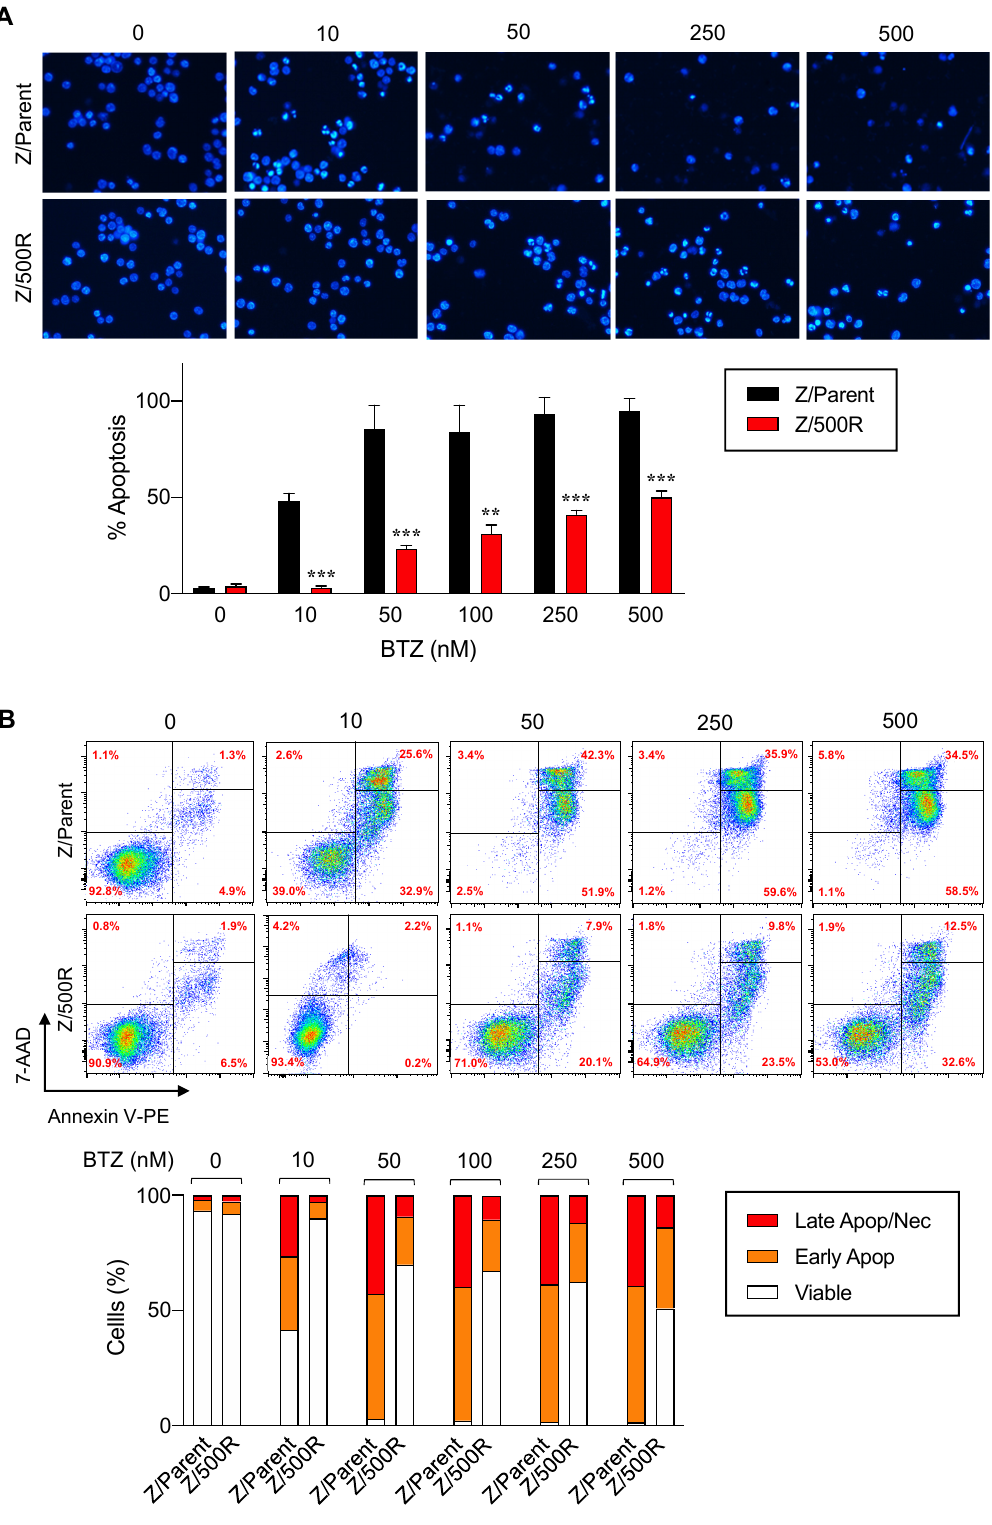
Figure 2. Resistant phenotype of the highly BTZ-resistant MCL cells in comparison to parental cells. ( A ) Parental Z/Parent and highly BTZ-resistant Z/500R cells were treated with BTZ (0–500 nM) and apoptosis was evaluated by the Hoechst 33342 assay at 24 h. ( Upper ) Representative micrographs of Hoechst 33342 nuclear staining under an inverted fluorescence microscope. ( Lower ) Percentages of apoptotic cells, which displayed condensed and/or fragmented nuclei, were scored from the micrographs and plotted. Data are mean ± SD ( n = 3). ** p < 0.01, *** p < 0.001 versus Z/Parent cells; two-